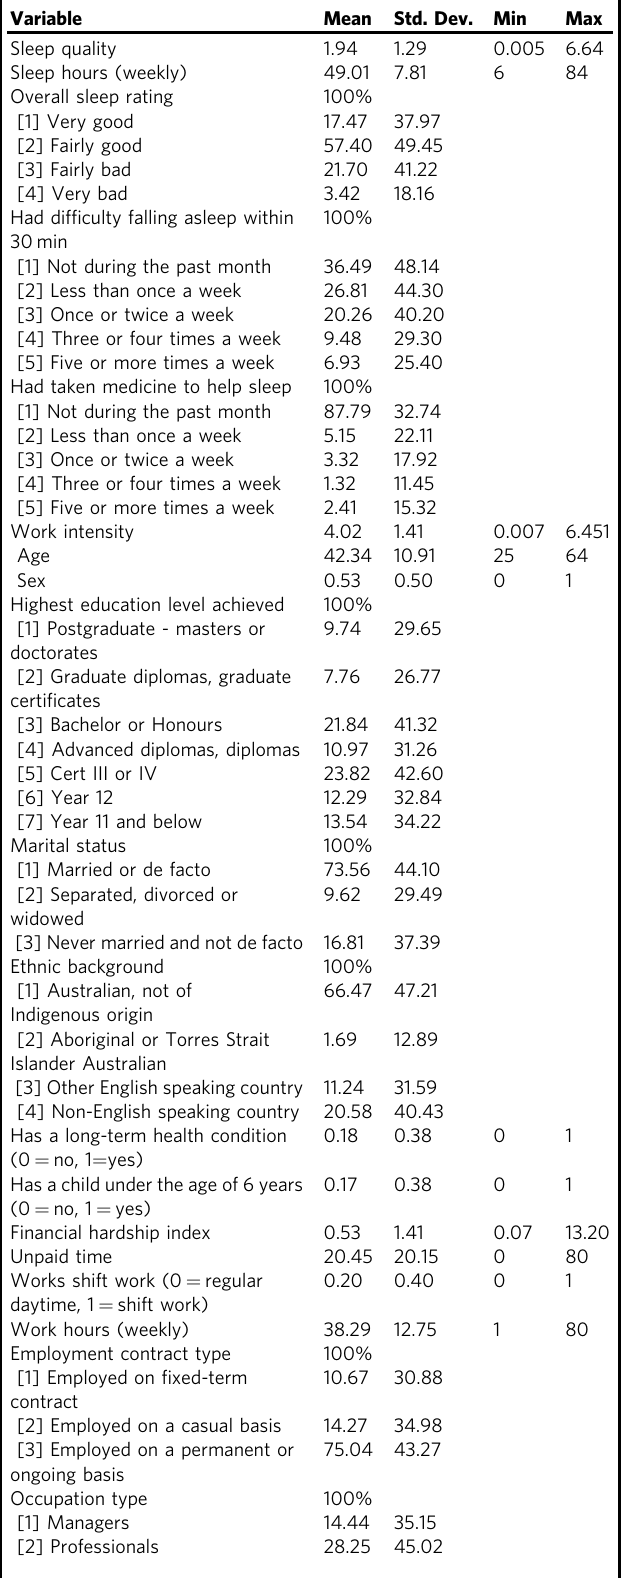
Table 1 Descriptive statistics of sample for